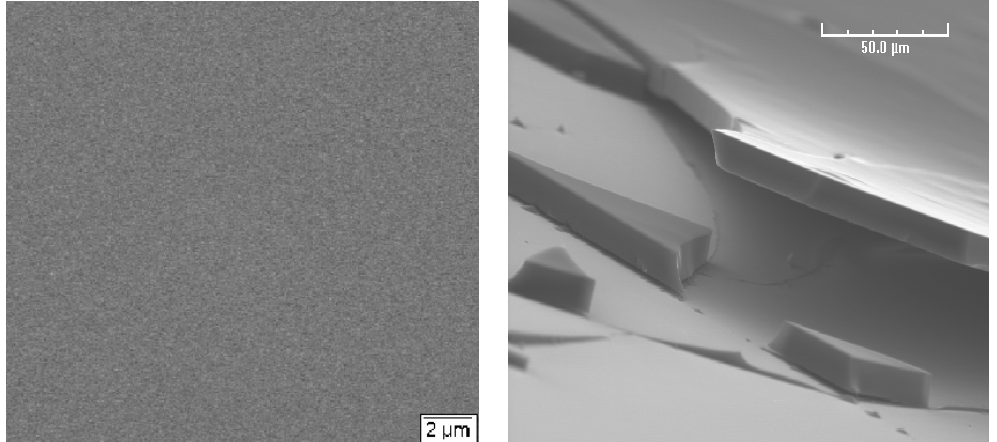
Figure 1. SEM Images of Carbon